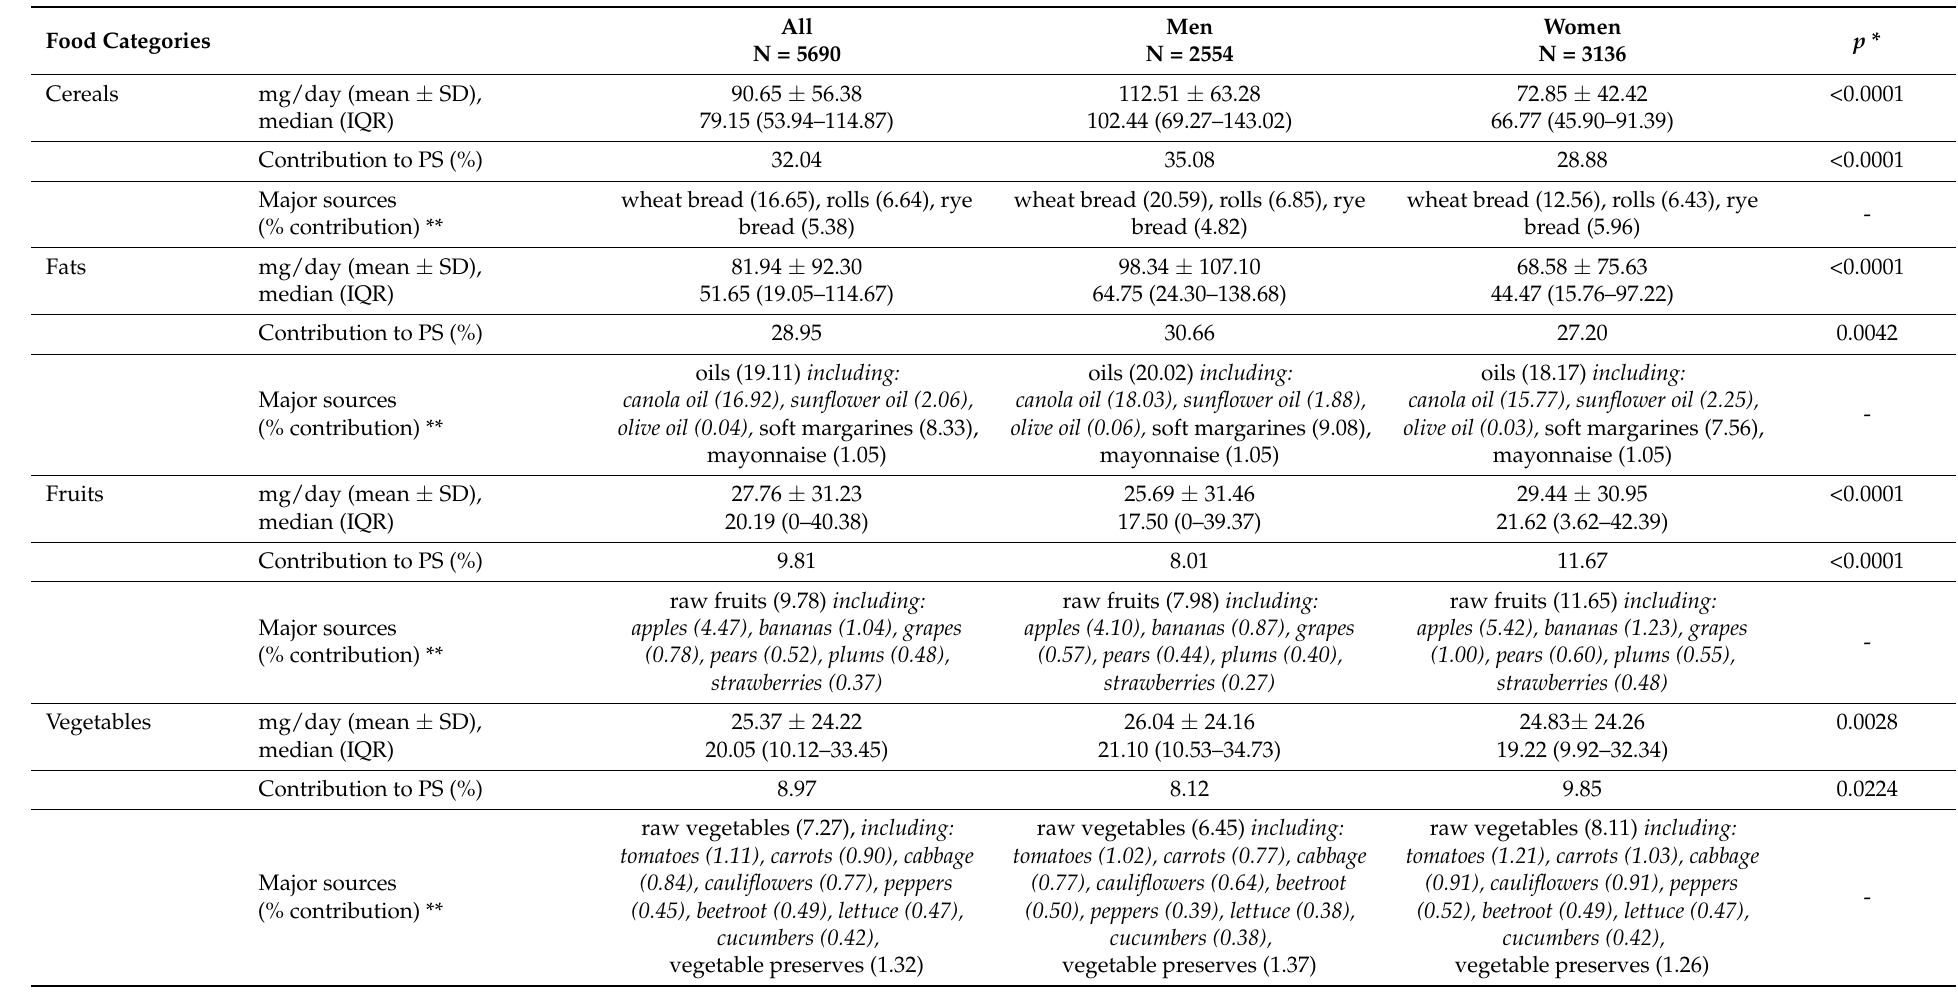
Table 2. Contributions of food categories and individual food products to total plant sterol intake (PS), listed according to diminishing order of